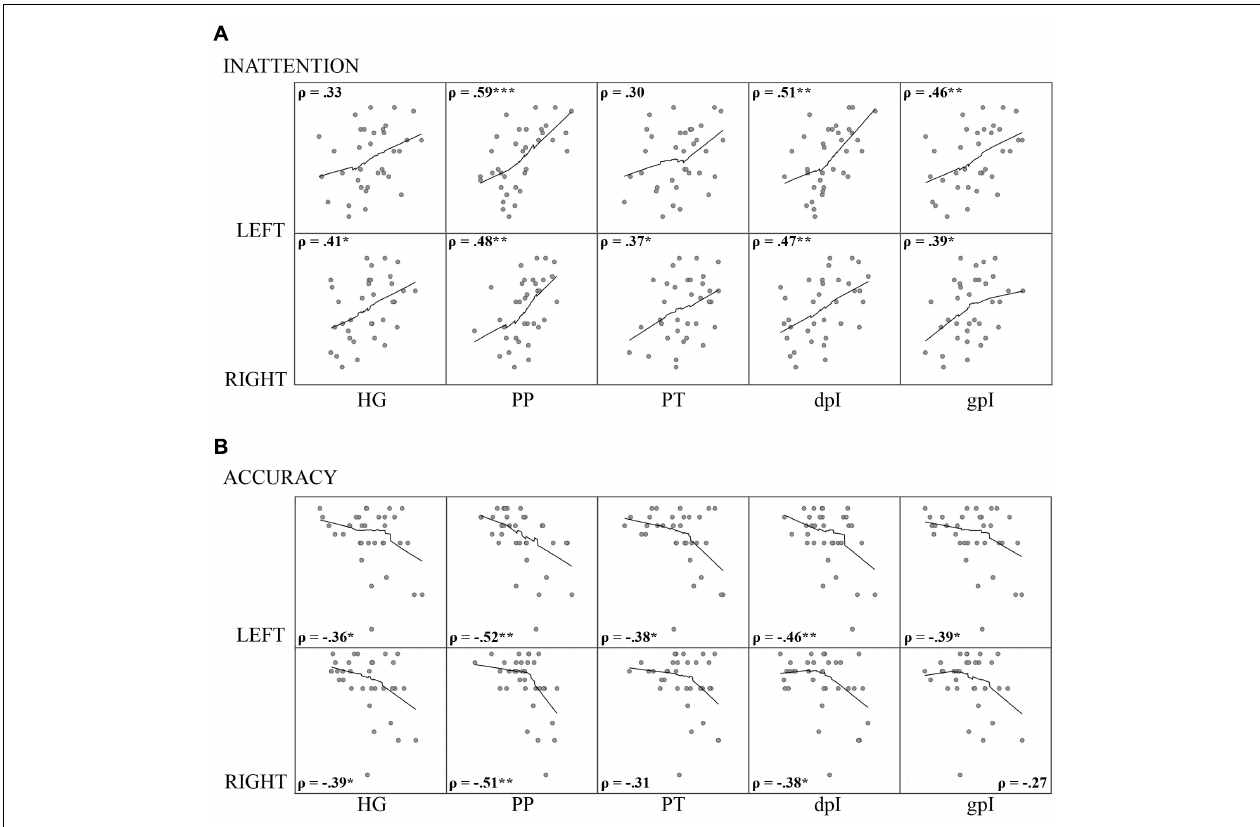
FIGURE 5 | Results of auditory ROI Spearman’s rho ( ρ ) correlation analysis between the mean change in attenuation under high visual working memory load (2-back–ATD) and (A) self-rated inattention; and (B) 2-back task accuracy performance. Upper and lower rows of scatter plots correspond to left and right hemispheres, respectively. Asterisks indicate the correlation was significant (two-tailed) at thresholds: * p < 0.05; ** p < 0.01; *** p < 0.001. Loess trend lines were approximated from a data span of 0.75 with a gaussian kernel. HG, Heschl’s gyrus; PP, planum polare, PT, planum temporale, dpI, dysgranular posterior insula; gpI, granular posterior